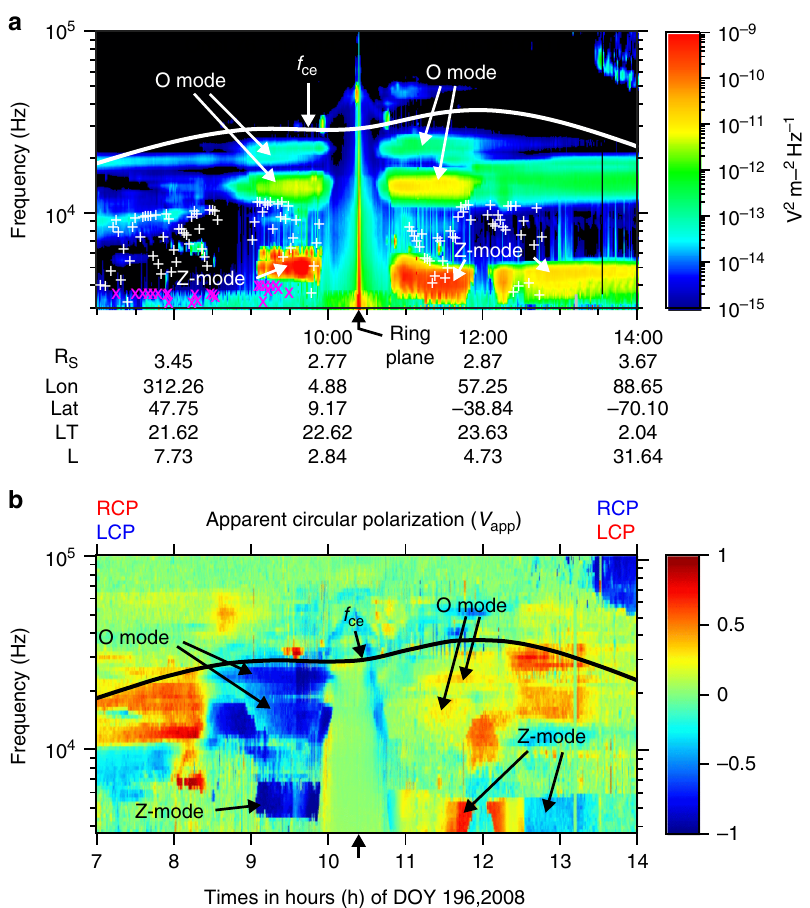
Fig. 1 Z-mode and O-mode emission observed by the Cassini RPWS instrument. a Electric fi eld power spectral density from RPWS on Cassini. The electron gyro frequency, f ce , is marked by the solid white line. The white plus signs indicate the plasma frequency and the pink crosses mark the L mode cut-off frequency. b Apparent circular polarization 20,21 as observed by the RPWS for the same time period. Prior to 10:23, apparent circular polarization <0 (blue) is left-hand polarized; after this time >0 (red) is left-hand polarized as indicated by the labels RCP and LCP in the fi